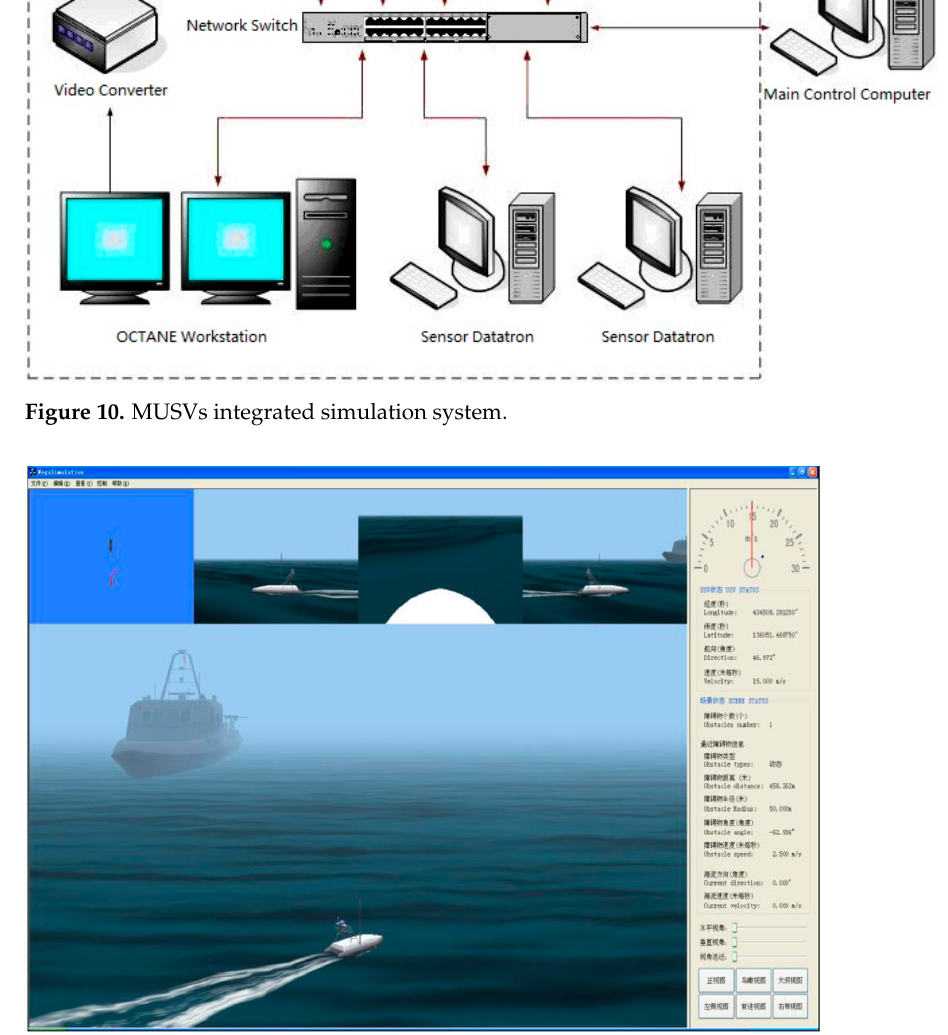
Figure 11. Interface of visual simulation.